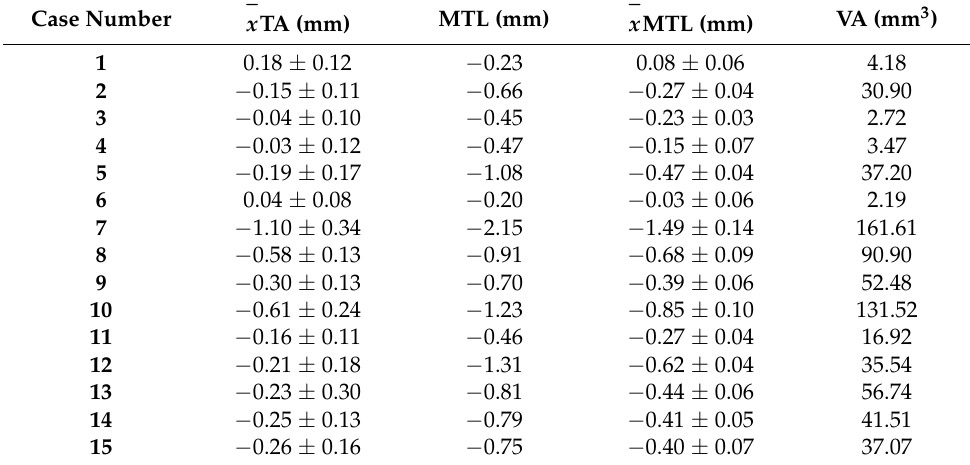
Table 1. Variable values obtained by T0-T1 STL